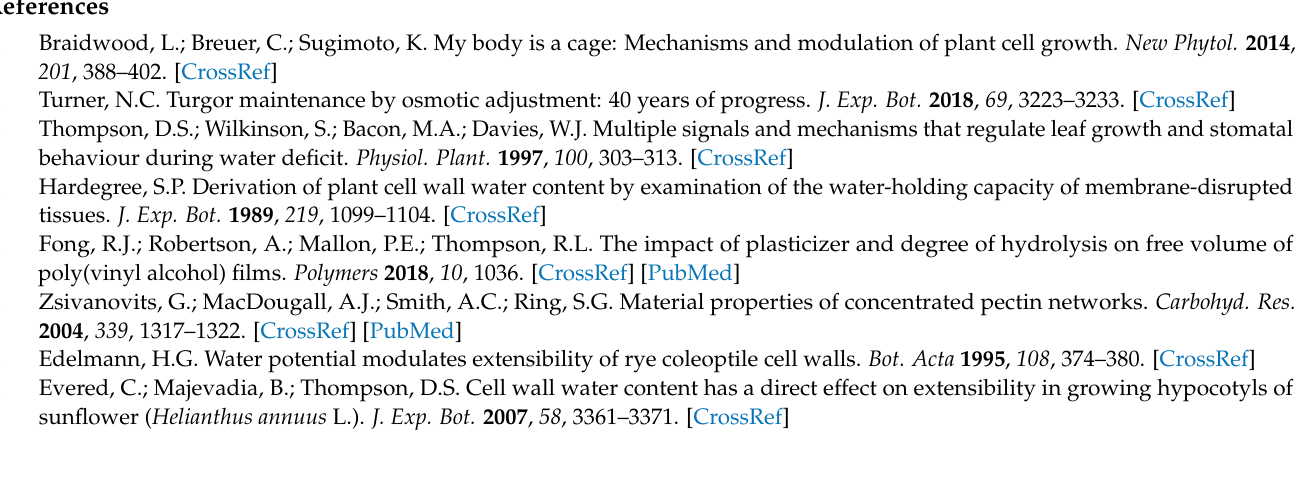
Figure A2. Image of tubes containing 2% ( w / v ) solutions of apple pectin of pH 3.03, 3.46, 3.99, 4.59, 5.05, 5.45, and 6.01 containing 10 mM CaCl 2 five minutes after the tubes were inverted.